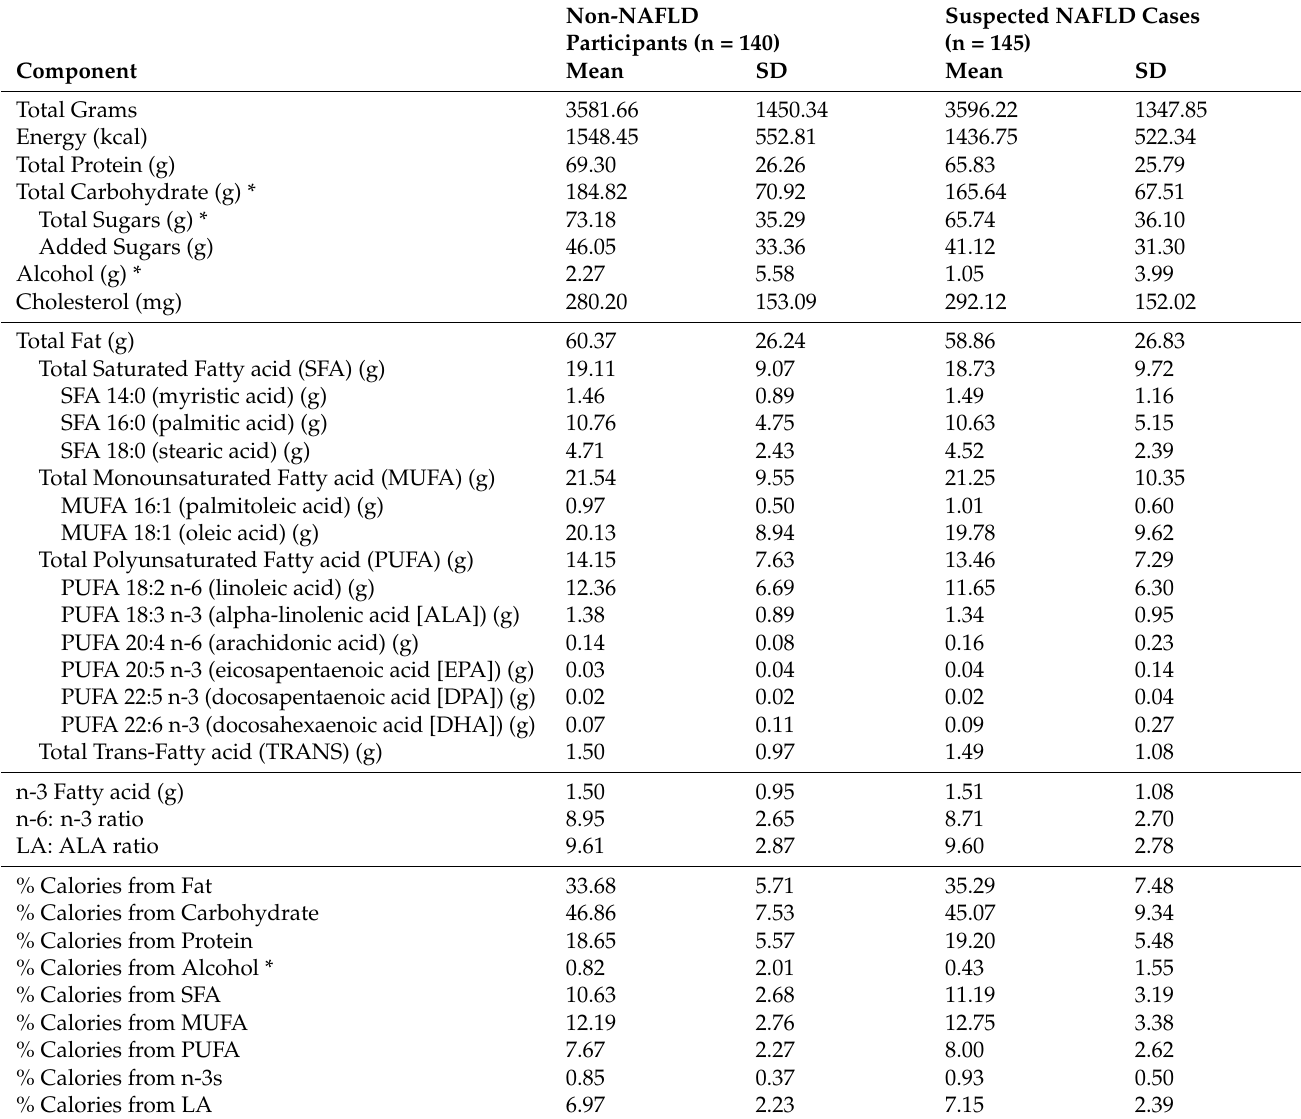
Table 2. Dietary intake values by suspected NAFLD Status in a Mexican-origin Hispanic sample from Southern Arizona (N = 285). Non-NAFLD Suspected NAFLD Participants (n = 140)